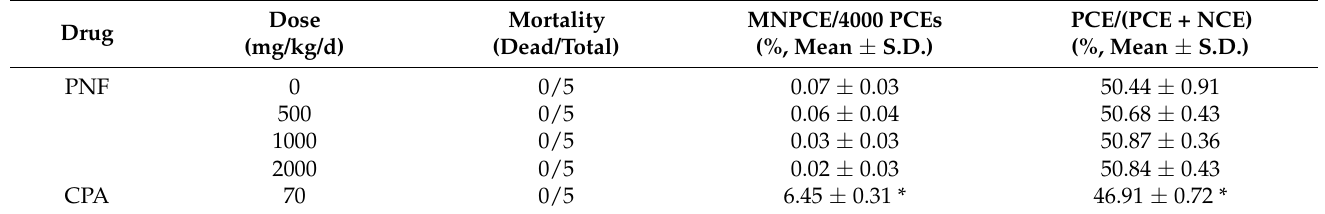
Table 6. Results of the micronucleus test in ICR mice exposed to oral treatment of puree of noni fruits